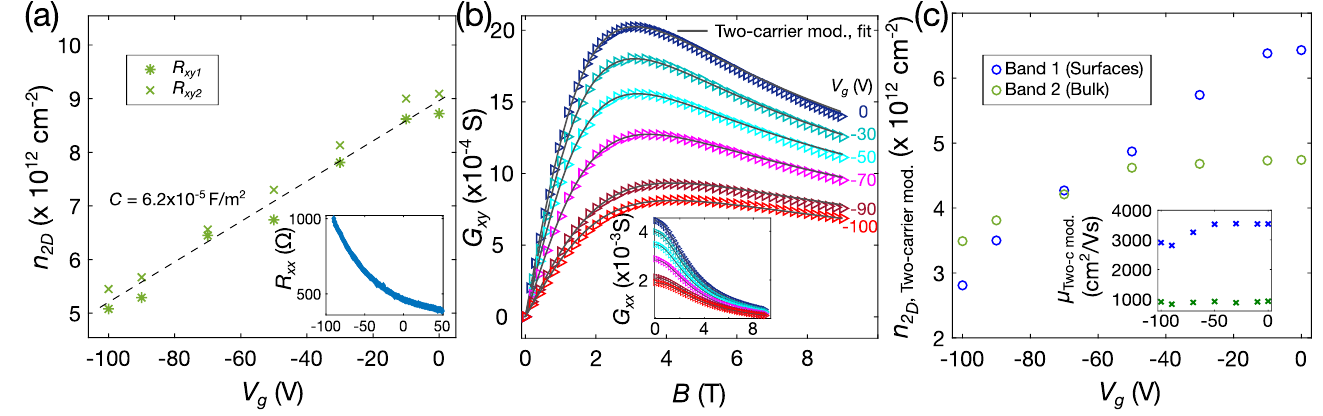
Figure 3. ( a ) Charge carrier density n 2 D (= n 3 D t ) as a function of the back-gate voltage V g . Here, n 2 D is calculated from the anti-symmetrized R xy ( B ) data in the 0–2.5 T range. R xy 1 and R xy 2 represent the Hall resistances measured using two different pairs of transversal electrodes, on the same nanoribbon. Black dashed line is the linear fit, and the capacitance estimated from the slope is 6.2 × 10 − 5 F/m 2 . In the inset—longitudinal resistance R xx as a function of the V g ; ( b ) conductance tensor element G xy ( B ) at different applied V g , fitted with the two-carrier model, inset shows fitted G xx ( B ) curves; ( c ) from the two-carrier model extracted parameters of the two bands: carrier densities n 1 ; n 2 , and mobilities µ 1 ; µ 2 (in the inset) versus the back-gate voltage. All the data shown correspond to the ZnO/Bi 2 Se 3 nanoribbon